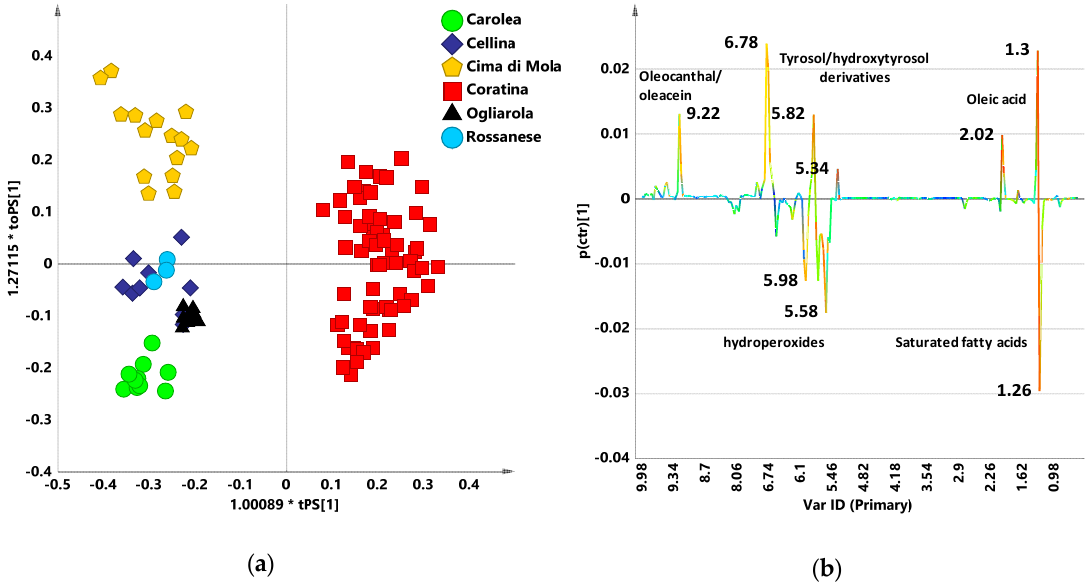
Figure 5. ( a ) OPLS-DA t[1] / t[2] scores plot for the monocultivar EVOOs data sets built with bucket reduced combined zg-noesy NMR spectra. One predictive and one orthogonal components account for R 2 X 0.579; R 2 Y 0.945; Q 2 0.936; 1.0089*tPS[1]; 1.27115*toPS[1]: axes scaled proportionally to R 2 X. ( b ) S-line plot for the model visualizing the p(ctr)[1] loading colored according to the absolute value of the correlation loading, p(corr)[1].